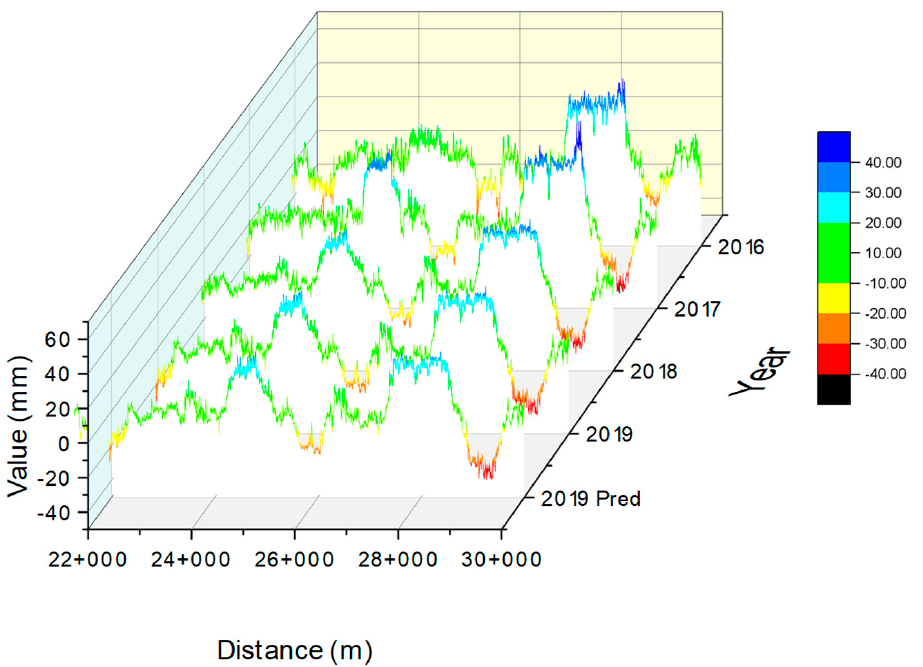
Figure 12. A 3D plot presenting time-series superelevation.